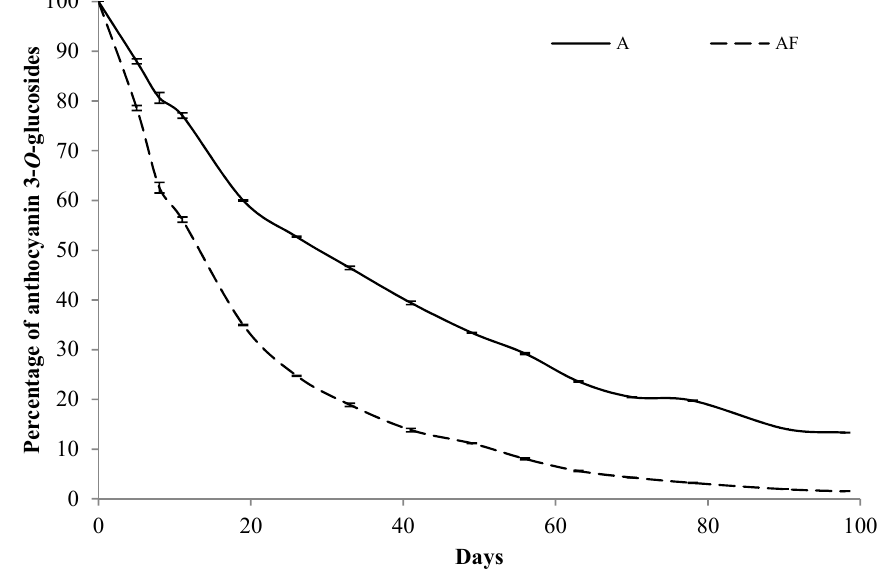
Figure 2. Evolution of the mean percentage ( n = 6) of the total content of the anthocyanins in relation to their initial content in the model systems containing only anthocyanins in standard model wine ( A ) and in the solution resulting from fermentative metabolism of glucose ( AF ).